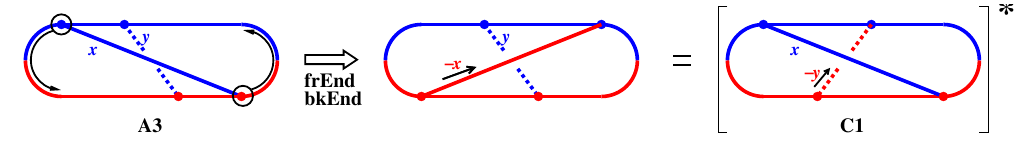
Figure 18 . Obtaining the C1 diagram from the A3 diagram by front- and back-end transformation and complex